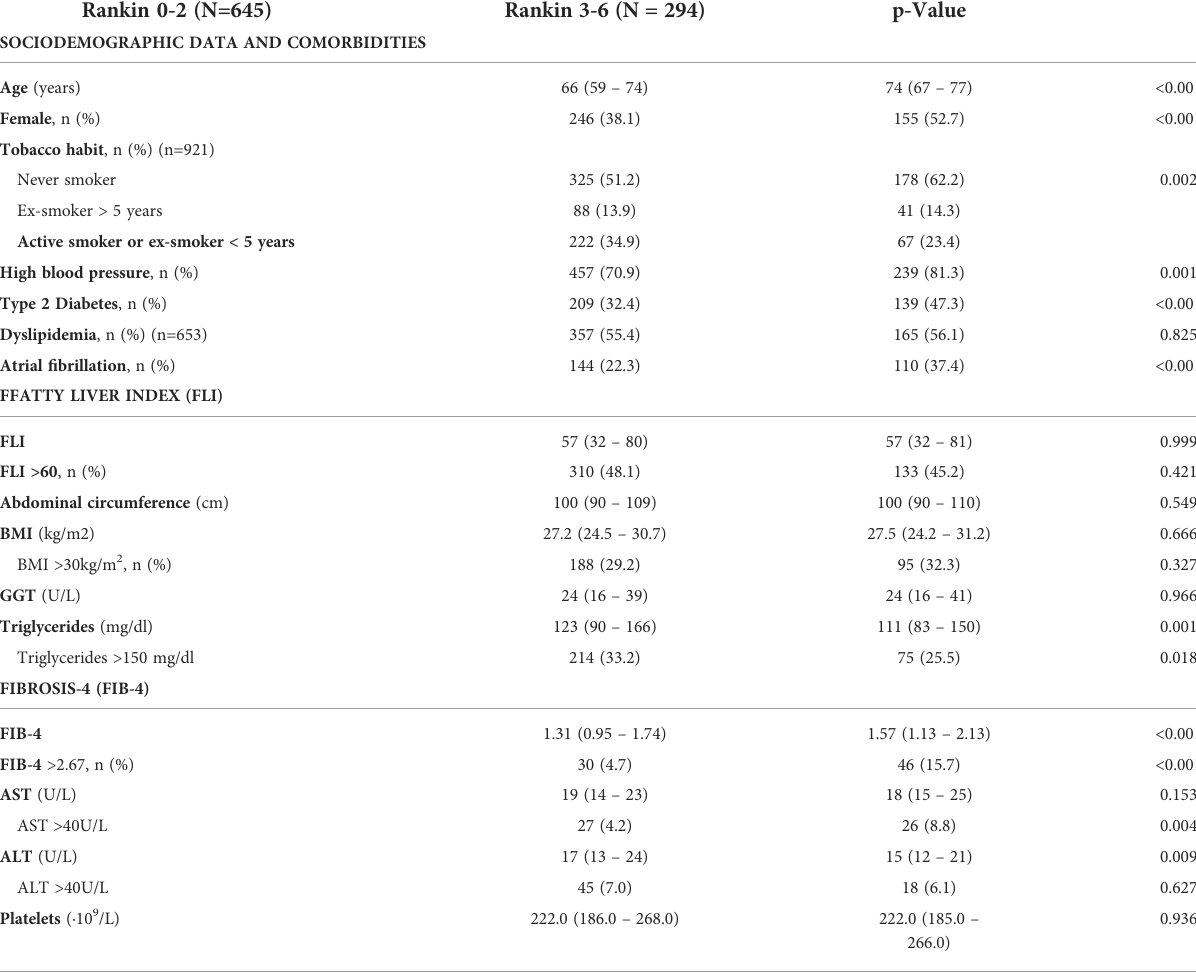
TABLE 4 Univariate analysis to assess factors related to worse prognosis (Rankin 0-3 vs. Rankin 3-6) in patients between 40 and 79 years old with a fi rst acute ischemic stroke (n=939).